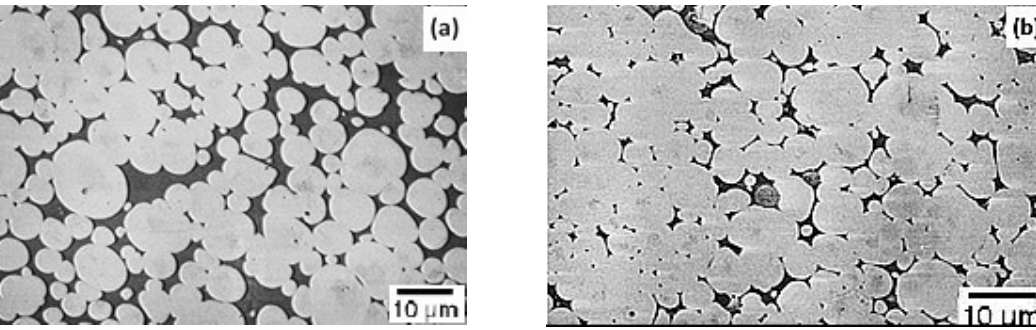
Figure 6. Microstructure of the W–Ni–Fe-Mo alloy ( a ) without La and ( b ) with 0.4% La [71]. Reproduced with permission from Wu et al., International Journal of Refractory Metals and Hard Materials; published by Elsevier, 1999.